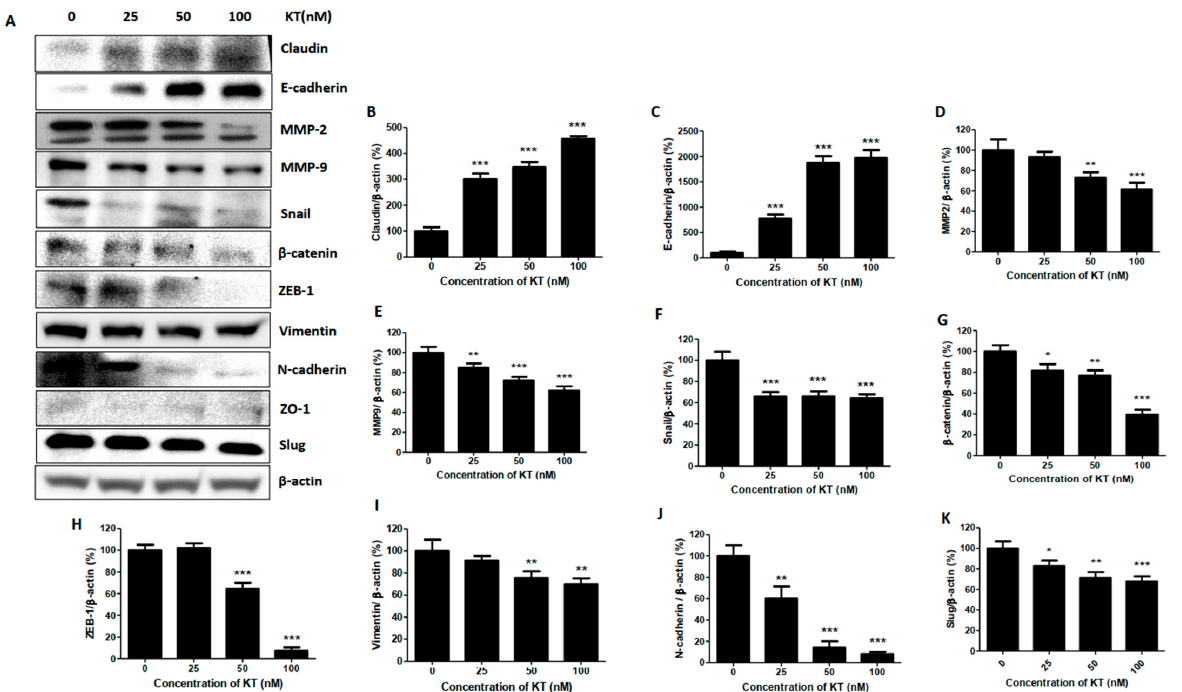
Figure 2. KT suppresses breast cancer epithelial-mesenchymal markers. Cells were cultured with DMEM high glucose (growth media) with or without 25, 50, and 100 nM concentrations of KT. ( A ) Western blot analysis was performed to determine the expression of breast cancer EMT marker proteins. ( B – K ) Quantitative analysis of the expression of EMT marker proteins. Results are presented as means ± S.D. ( n = 3). * p < 0.05, ** p < 0.01, and *** p < 0.001 indicate significant differences between KT-treated groups and control.